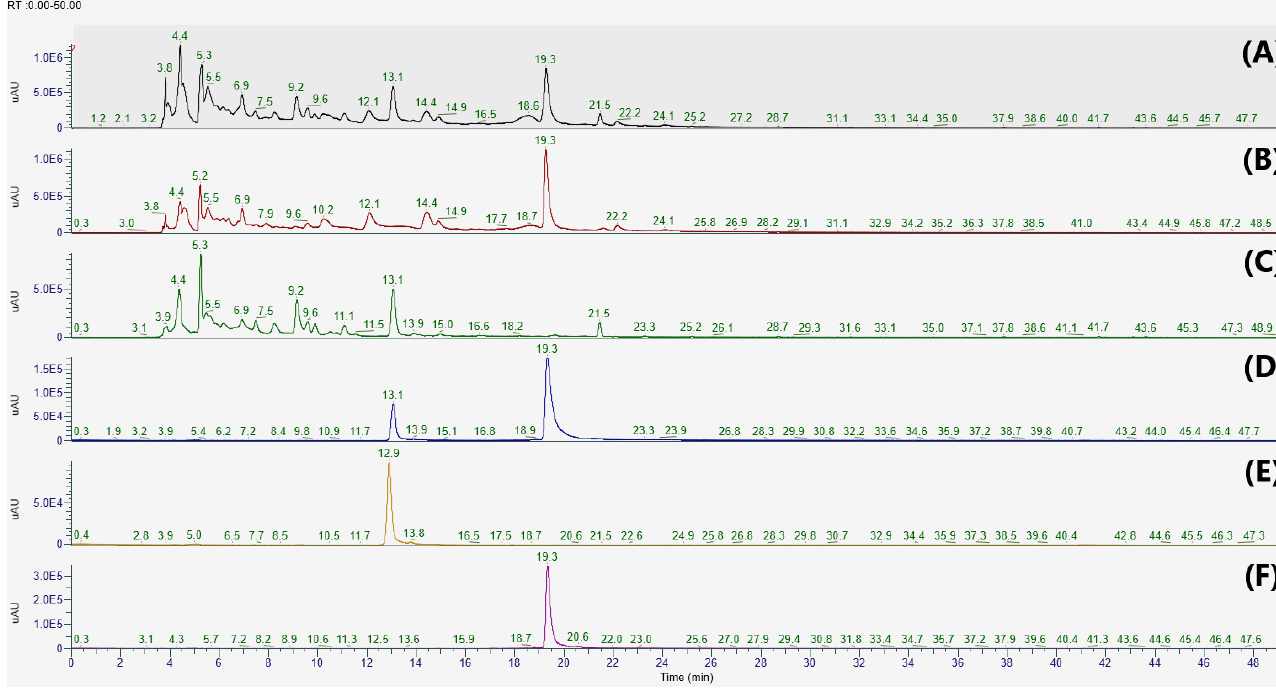
Figure 1. HPLC chromatograms of ( A ) a botanical mixture of 30% EtOH extracts from the leaves of Inula japonica and Potentilla chinensis , ( B ) 30% EtOH extracts of I. japonica Thunb, ( C ) 30% EtOH extracts of P. chinensis Ser., and ( D – F ) standard solutions at 280 nm. Apigenin 7- O - β - D -glucuronide and 2,3,4,5-tetracaffeoyl- D -glucaric acid were detected at R t 13.1 and 19.3 min, respectively.